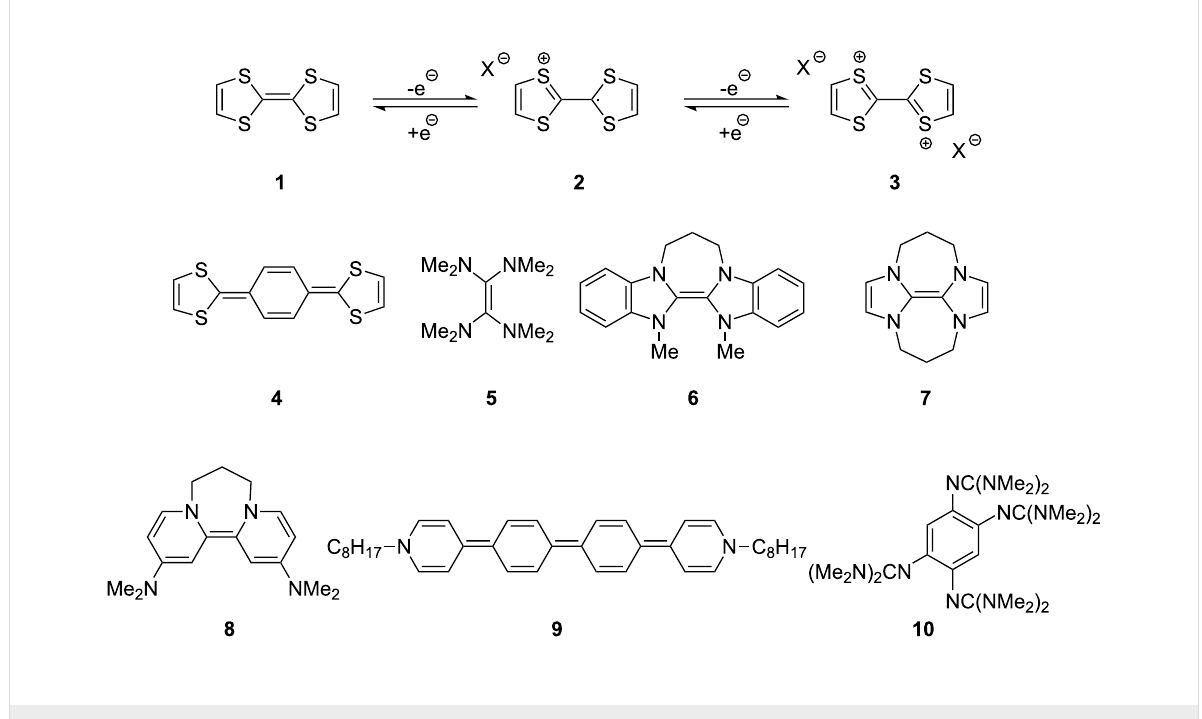
Figure 1: Neutral organic electron donors 1 and 4 – 10 .